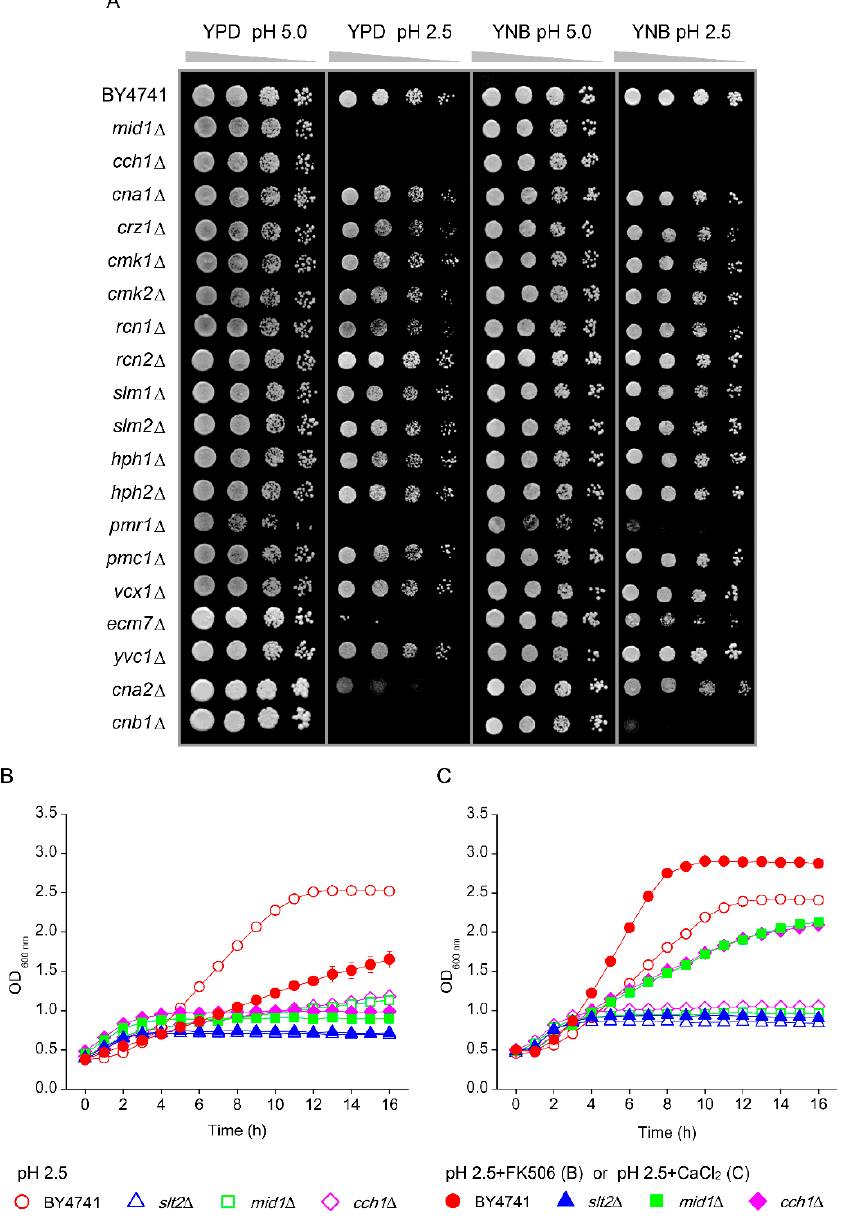
Figure 2. Screening for the involvement of Ca 2+ transport and signalling pathway on the yeast tolerance to low pH ex . ( A ) S. cerevisiae BY4741 wild type strain and isogenic mutants were cultivated in YPD medium and serial dilutions (1/10) of yeast cultures were spotted on YPD or YNB agar media adjusted to pH 5.0 or 2.5 with sulphuric acid. Plates were incubated for two days at 30 °C. ( B ) Cells of BY4741 (red circles) and its isogenic mutants slt2 ∆ (blue triangles), mid1 ∆ (green squares) and cch1 ∆ (pink diamonds) were cultivated in YNB adjusted to pH 2.5 with sulphuric acid (open symbols) or pH 2.5 in the presence (closed symbols) of the calcineurin inhibitor FK506 at 2 μ L/mL. ( C ) Cells of BY4741 (red circles) and its isogenic mutants slt2 ∆ (blue triangles), mid1 ∆ (green squares) and cch1 ∆ (pink diamonds) were cultivated in YNB adjusted to pH 2.5 with sulphuric acid (open symbols) or pH 2.5 in the excess of Ca 2+ at 37 mM CaCl 2 (closed symbols).